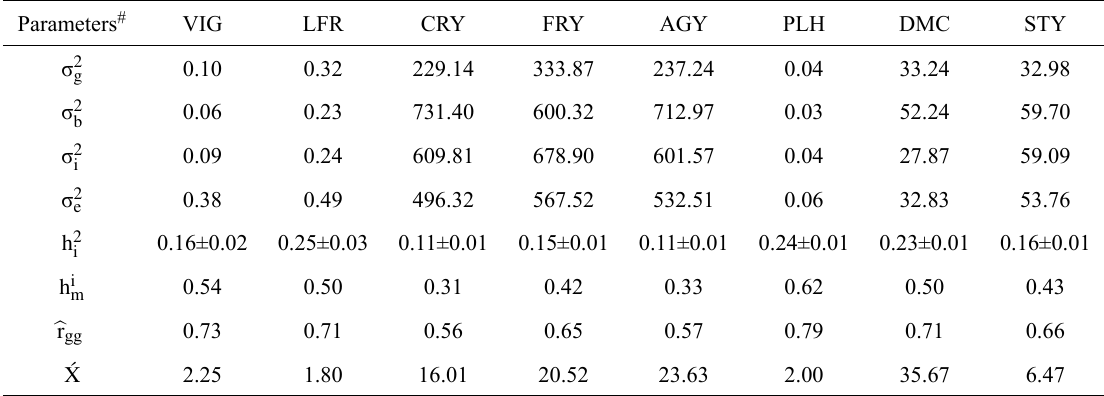
Genetic and phenotypic parameters estimated for plant vigor (VIG), leaf retention (LFR), commercial fresh root yield (CRY), total fresh root yield (FRY), above-ground yield (AGY), plant height (PLH), dry matter content (DMC) and starch yield (STY) of 814 cassava